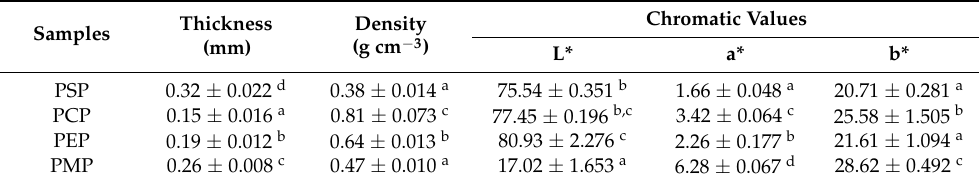
Table 1. Thickness, density, and chromatic values of four P. eryngii papery foods.